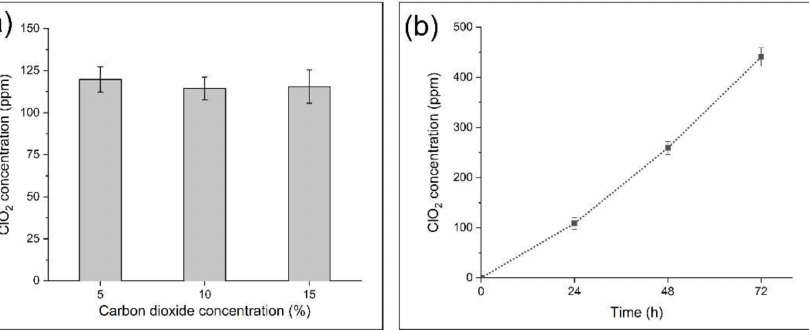
Figure 5. Effect of carbon dioxide concentration ( a ) and time ( b ) on ClO 2 -generating ability of 5 mg NaClO 2 -loaded PEO